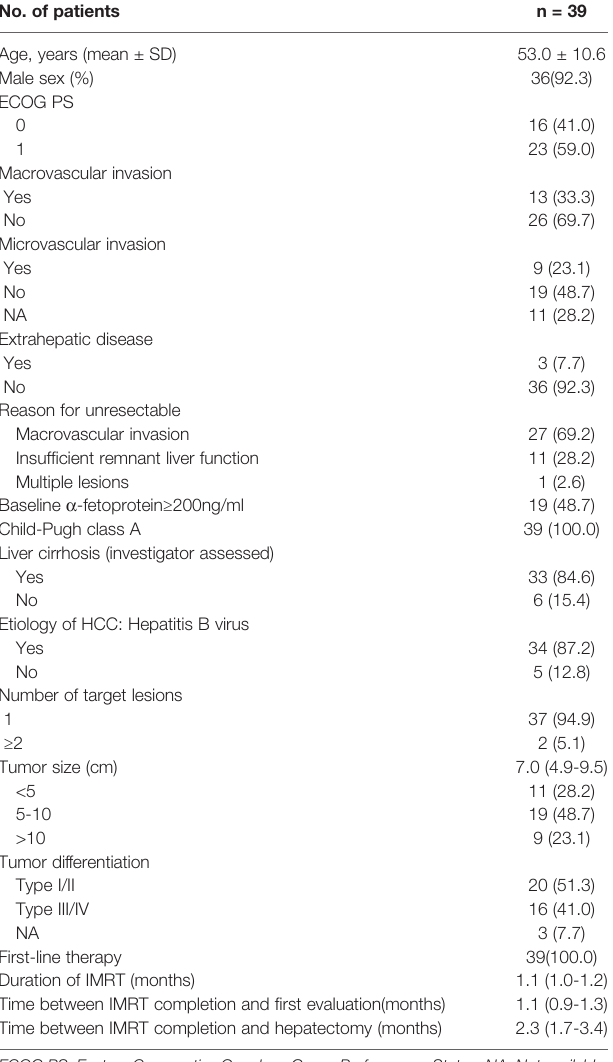
TABLE 2 | Patient and baseline